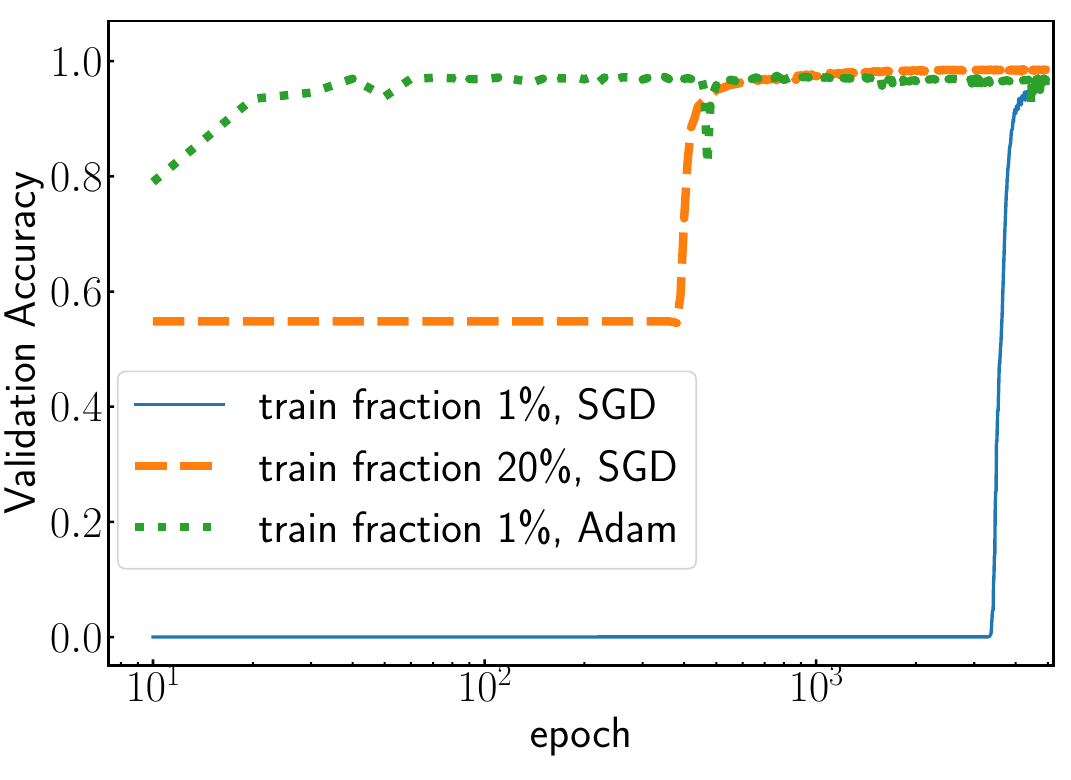
Figure 7 . The same as (cid:12)gure 6 but for central Au+Au collisions at p s = 11 GeV. 14 GeV and 94% for p s = 7 GeV, using the data set of primitive experimental observables, such as particle transverse momentum and azimuthal angle. Moreover, it is possible to di(cid:11)erentiate between equation of state using the model trained on di(cid:11)erent neighboring